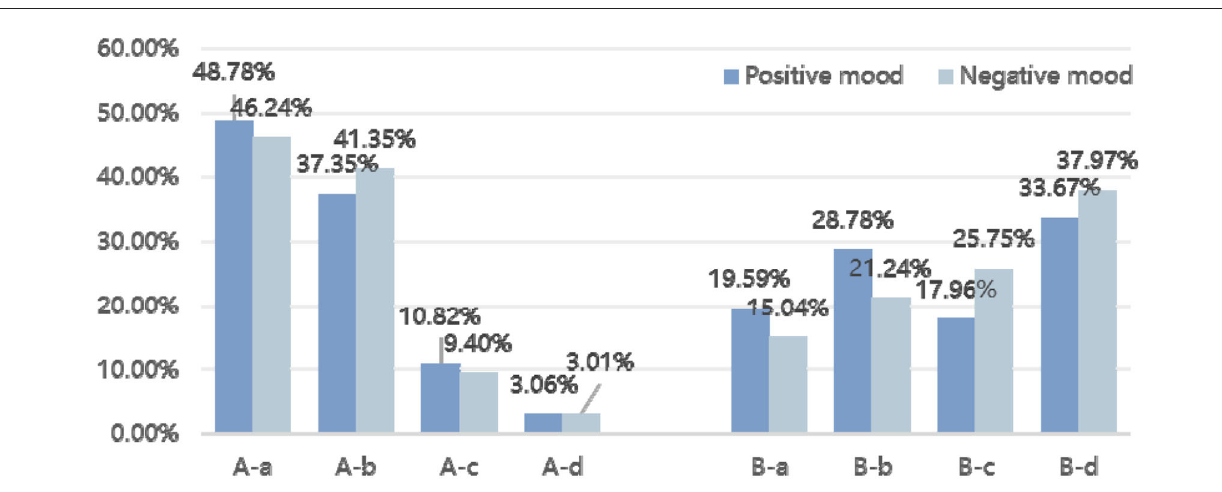
FIGURE 4 | The consistency and differences of the two perspectives for positive and negative moods based on the percentage of selected samples.